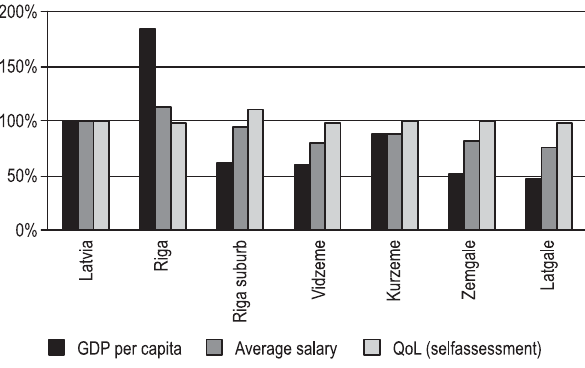
Fig. 13. Regional disparities in